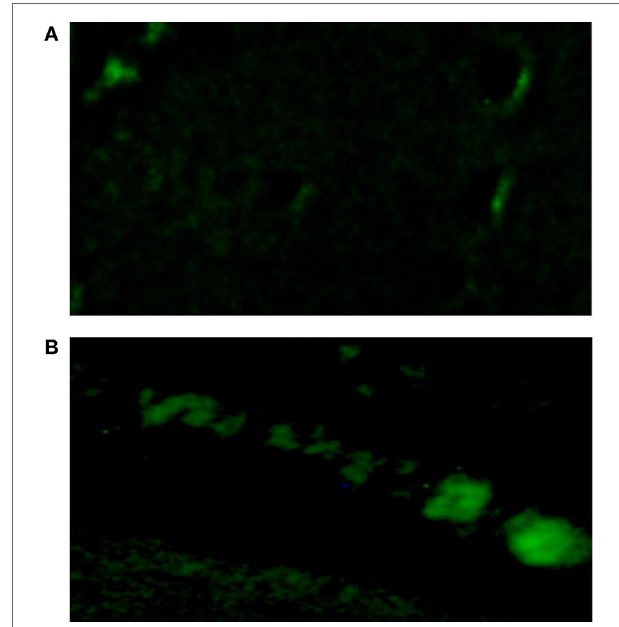
FigUre 5 | influence of aldosterone on oxidative stress . (a) Control fluorescence microscopy of single cell under control conditions, left bottom; (B) green fluorescence measured in the same cell after administration of aldosterone (100 nM).